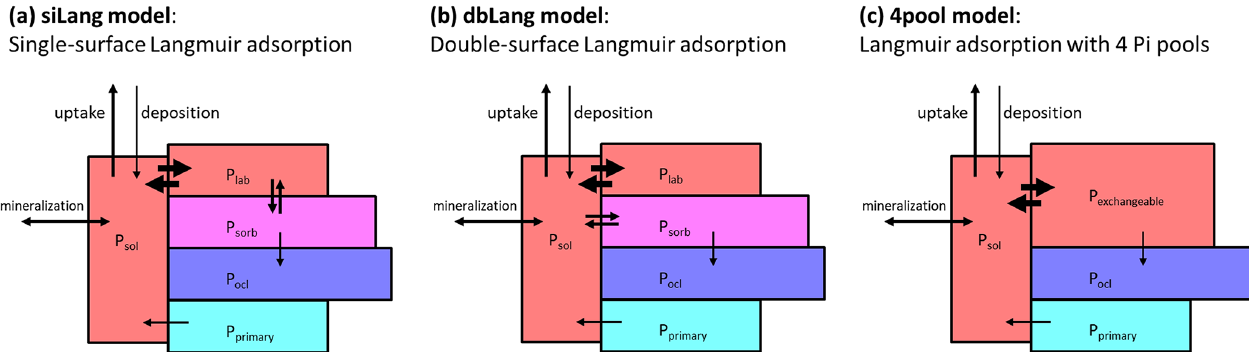
Figure 1. Model concept of (a) a conventional Langmuir model (siLang), where only the labile P pool (P lab ) is exchanging P with the soil solution (P sol ); (b) a double-surface Langmuir model (dbLang), where both P lab and P sorb are exchanging P with the soil solution but with different Langmuir parameters; and (c) a Langmuir model with only four inorganic P pools (4pool), where P lab and P sorb are combined to one pool (P exchangeable ) to which P sol can get adsorbed via Langmuir sorption. Table 1. Site characteristics of the Bad Brückenau (BBR), Mitterfels (MTF), Vessertal (VES), Conventwald (COM), and Lüß (LUE) study sites, based on Table 1 from Lang et al. (2017). In the soil measurement section of the table, values before the slash refer to the topsoil, and values after the slash refer to the